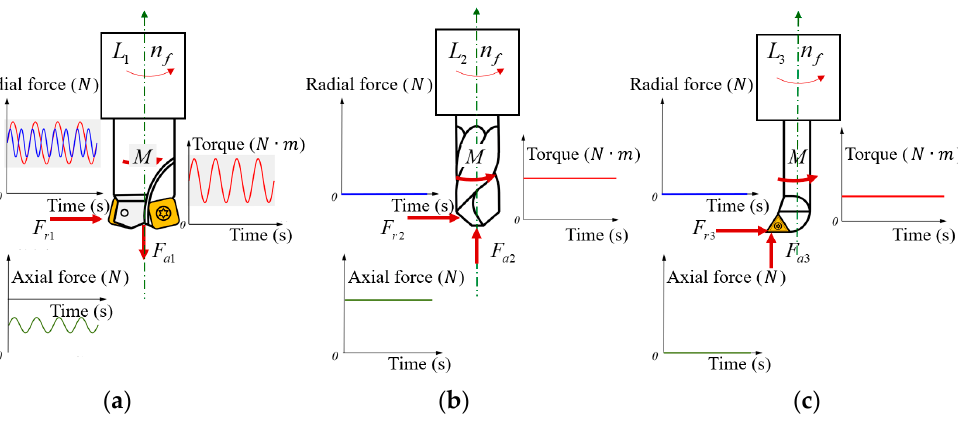
Figure 6. Schematic of cutting load pattern in different machining processes. ( a ) Load condition of milling. ( b ) Load condition of drilling. ( c ) Load condition of boring.